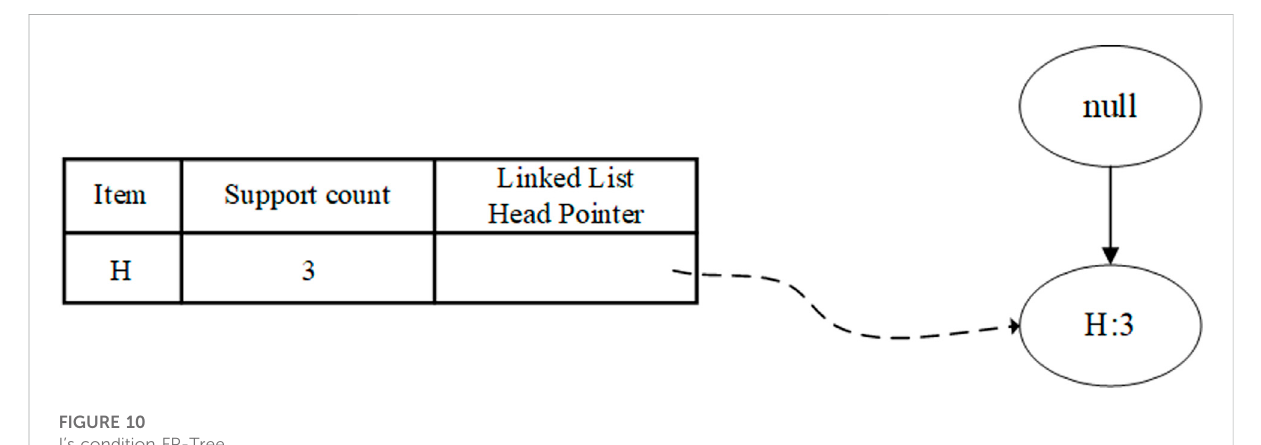
FIGURE 10 I ’ s condition